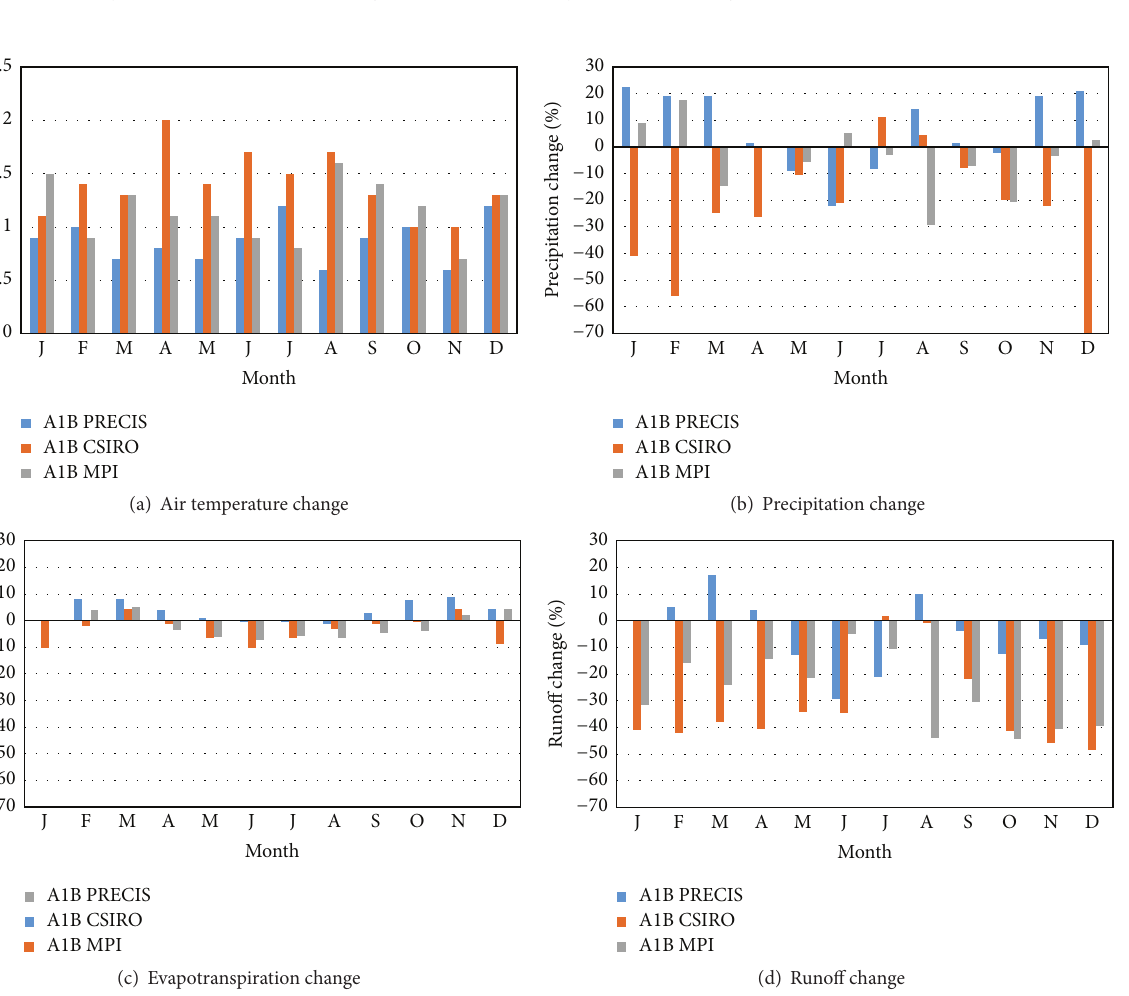
Figure 6: Projected changes in precipitation, air temperature, evapotranspiration, and runoff under A1B scenarios relative to baseline